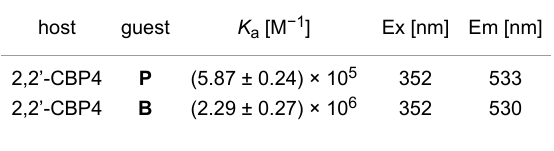
Table 1: Association constants ( K a /M − 1 ) for 1:1 intermolecular com- plexation of P and B with 2,2’-CBP4 in phosphate buffer solution (pH 7.4) at 298